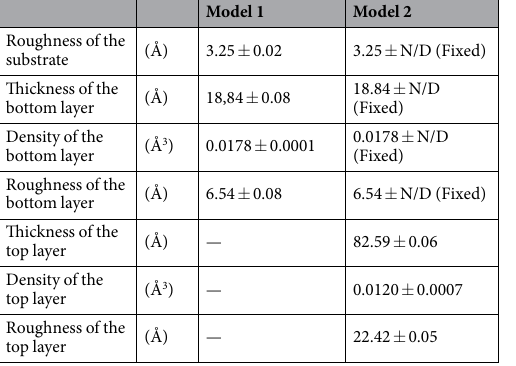
Table 2. Comparison between the results of the fitting of the XRR data with the two stack models.